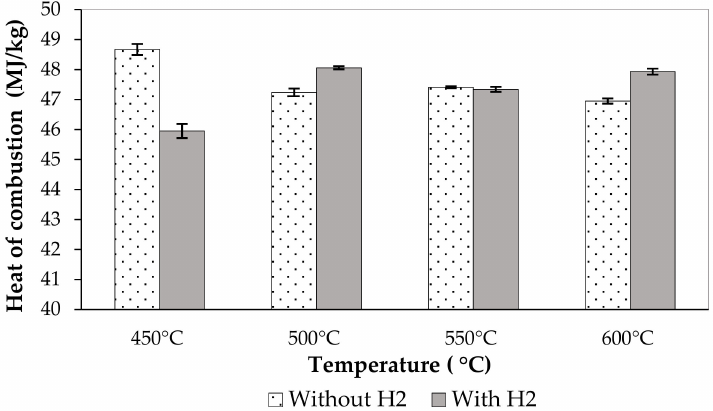
Figure 6. Heat of combustion of liquid fractions obtained at different temperatures with and without a constant flow of